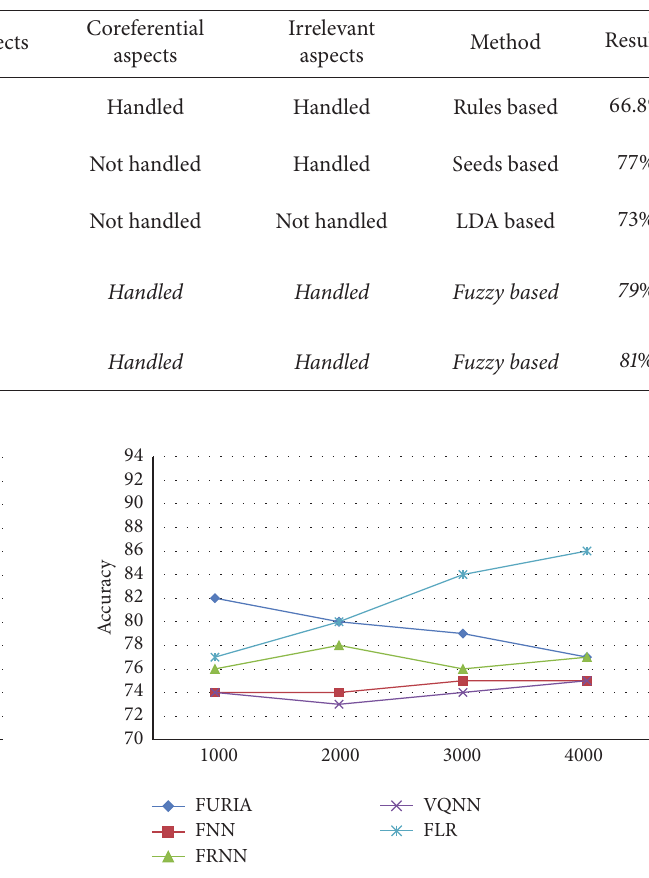
Table 4: Comparison with other aspects extraction methods.